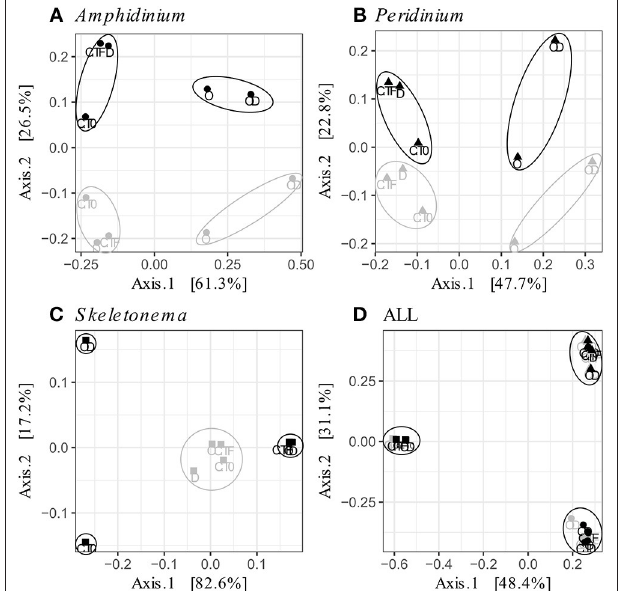
FIGURE 4 | Principal Coordinate Analysis (PCoA) based on Bray-Curtis dissimilarity of the phytoplankton-attached (gray) and the free-living (black) bacterial communities for each phytoplankton species: (A) A. carterae (circles), (B) P. sociale (triangles), (C) Skeletonema sp. (squares), and (D) all species together. Labels are the treatments: CT0 for control sampled at time 0, CTF for control sampled at final time point; D for dispersant, O for oil, and OD for dispersed oil all at final time point. The circles represent the significant clusters as determined by